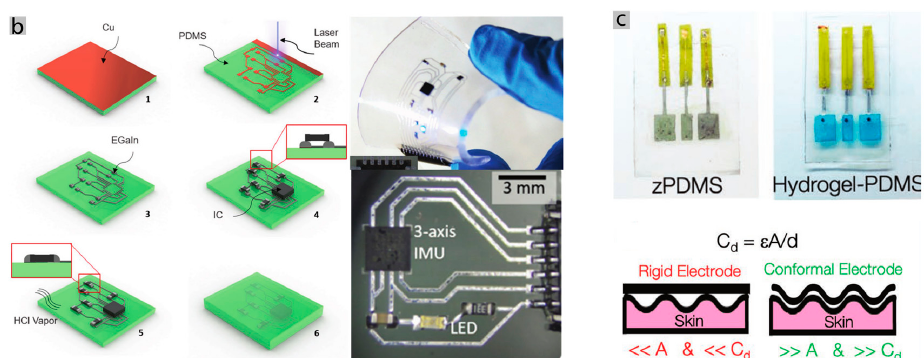
Figure 5. The interfacing challenge ( a ) A mechanic-acoustic detecting sensor with copper serpentine traces encapsulated in polyimide. This device is stretchable and capable of detecting sounds, specifically heart rate and murmur sounds, thanks to its skin-interfacing electrodes. Adapted with permission from [98]. ( b ) Interfacing EGaIn with rigid microchips. The process uses a copper plate carved by the laser and selective wets to EGaIn. After the microchips are placed, an HCl vapor treatment “solders” them into place. Adapted with permission from [115]. ( c ) The lack of conformity that rigid electrodes present versus soft electrodes such have silver-coated nickel anisotropic conductor (ZPDMS) and hydrogel ones. These electrodes allow for a good skin-sensor interface. Adapted with permission from [34].